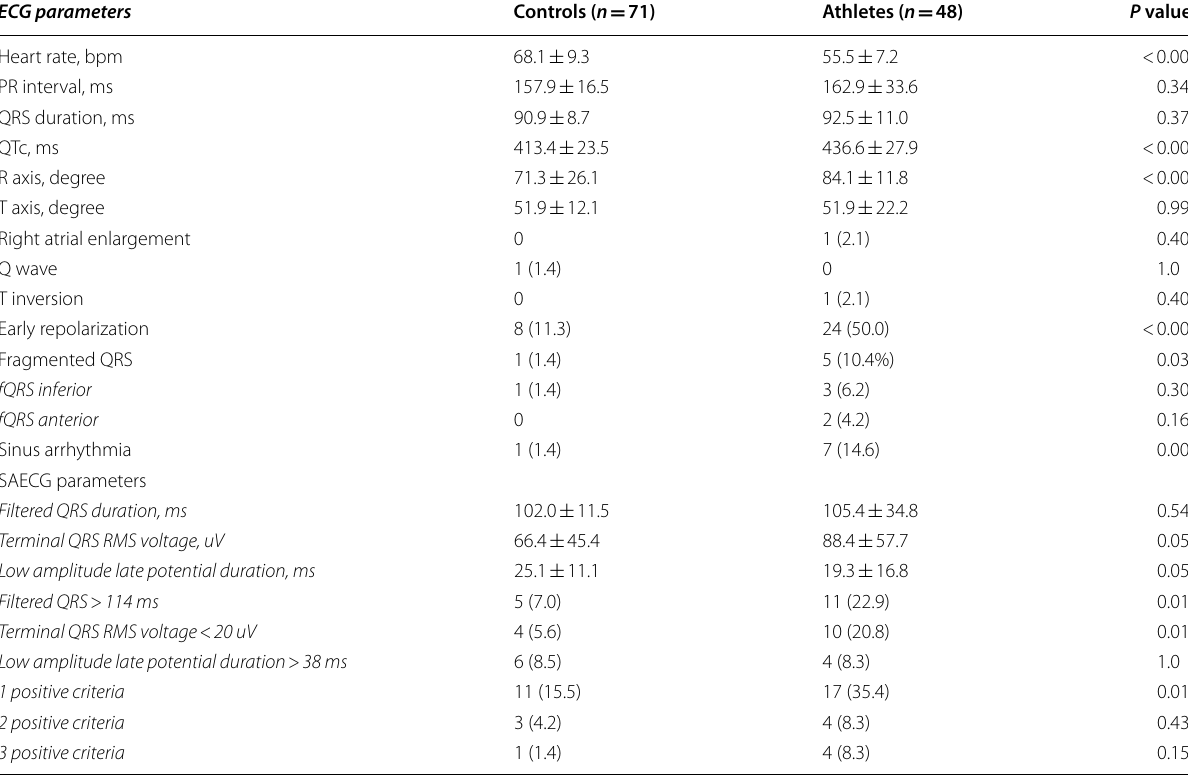
RMS, root mean square; SAECG, signal-averaged